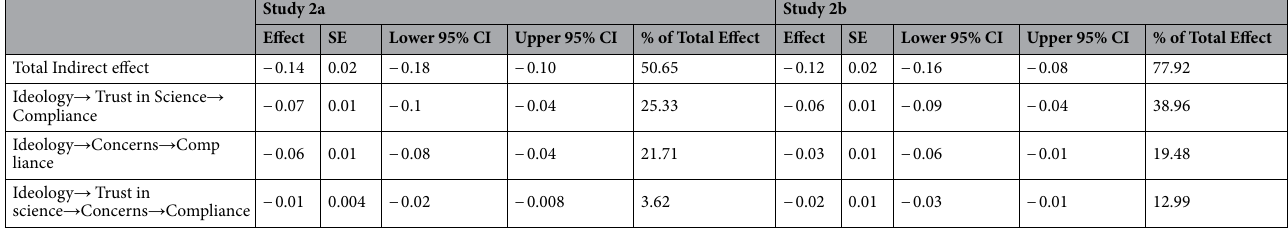
Table 2. Indirect effects depicted in Fig.